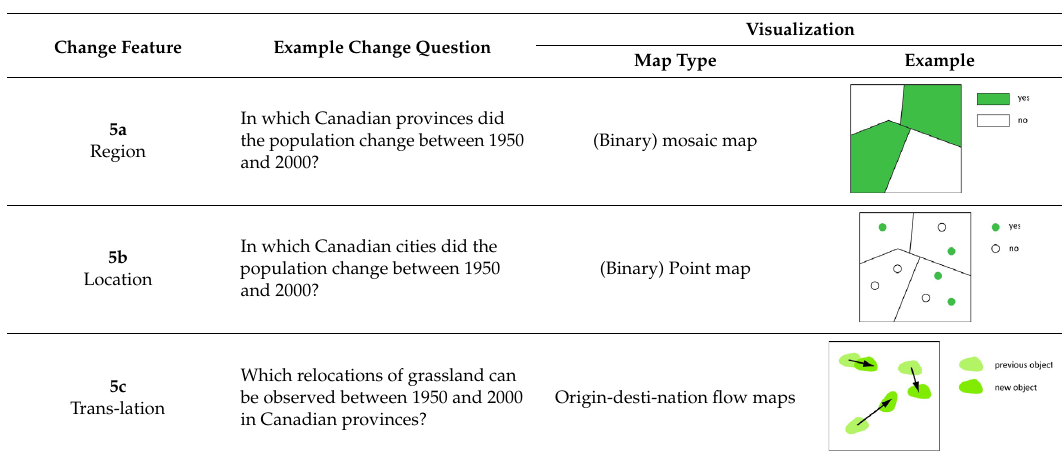
Table 5. Visualization of “Where” output clauses (compare classification in Table 2).